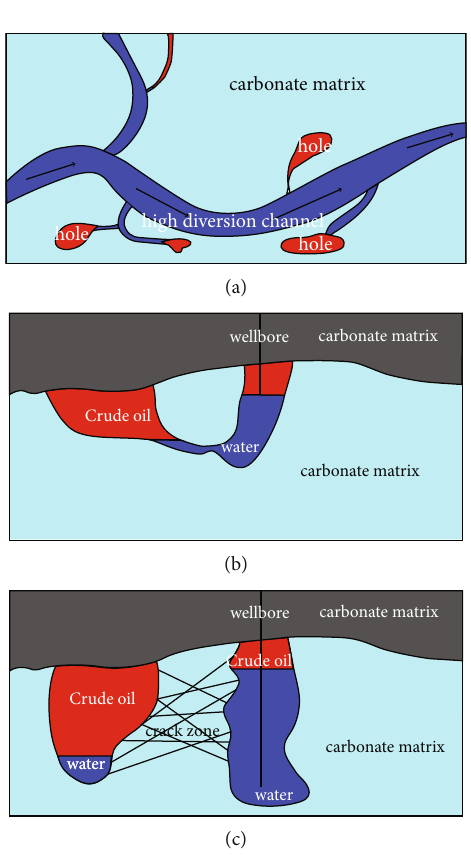
Figure 6: Well point residual oil mode.